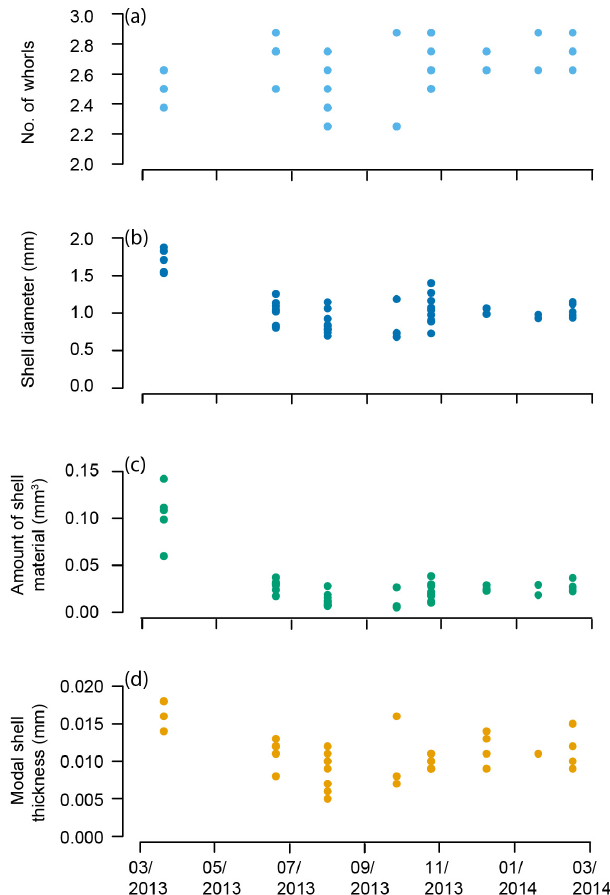
Figure 6. Heliconoides inflatus : (a) number of whorls, (b) shell di- ameter, (c) amount of shell material, and (d) modal shell thickness throughout the year in the Cariaco Basin. Each point represents an individual specimen.